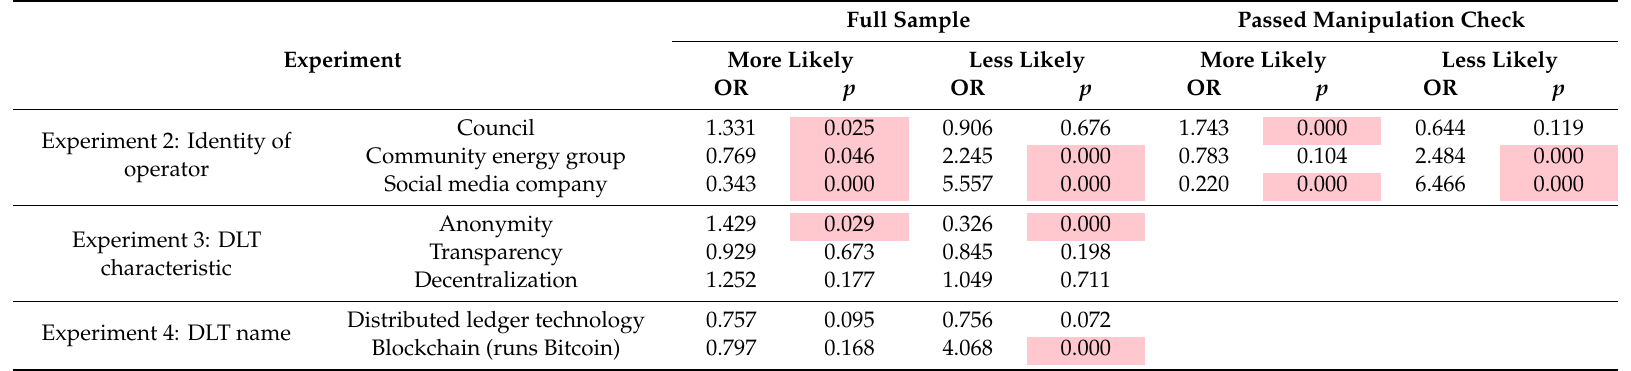
Table 5. Logistic regression results for Experiments 2 (reference category: energy supplier), 3 (reference category: immutability) and 4 (reference category: blockchain). Results shown are the odds ratio (OR) and p-value, with values lower than 0.05 shaded red. Experiment 2 was the only one for which a manipulation check was run. All significant p-values withstood correction for false discovery due to multiple comparisons by the Benjamini-Hochberg test